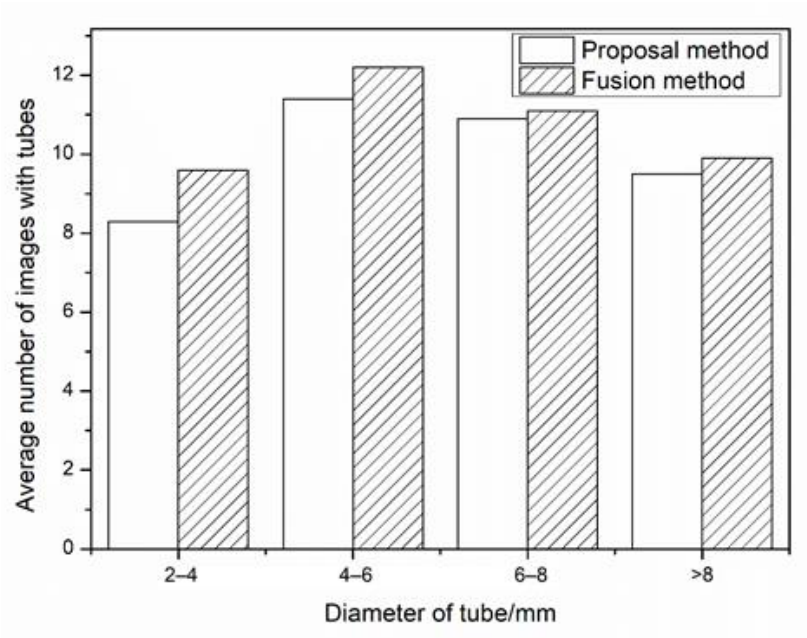
Figure 11. The average number of images with different tubes.